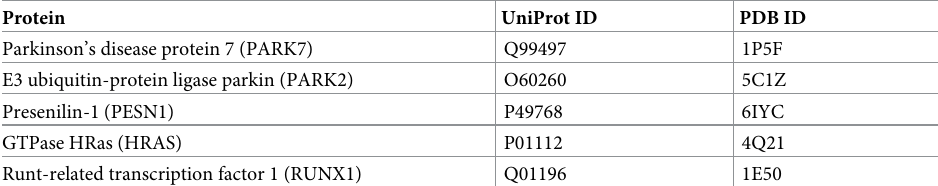
Table 2. UniProt IDs and PDB IDs of each